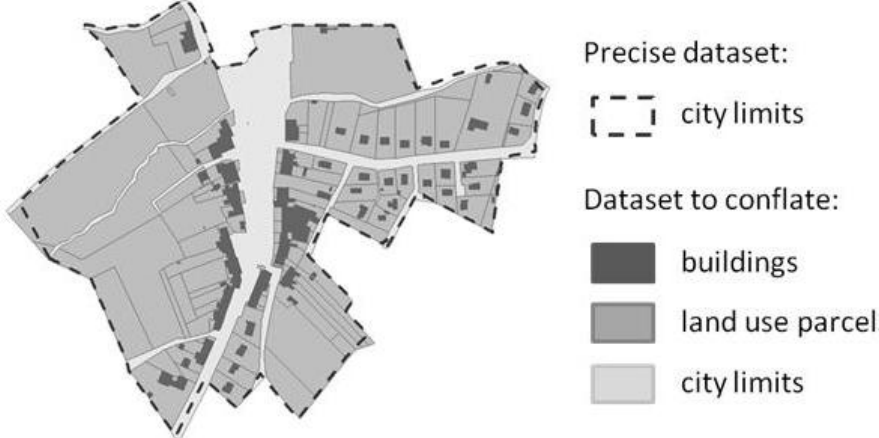
Figure 14. Extract of the less accurate dataset of the use case, to conflate with accurate city